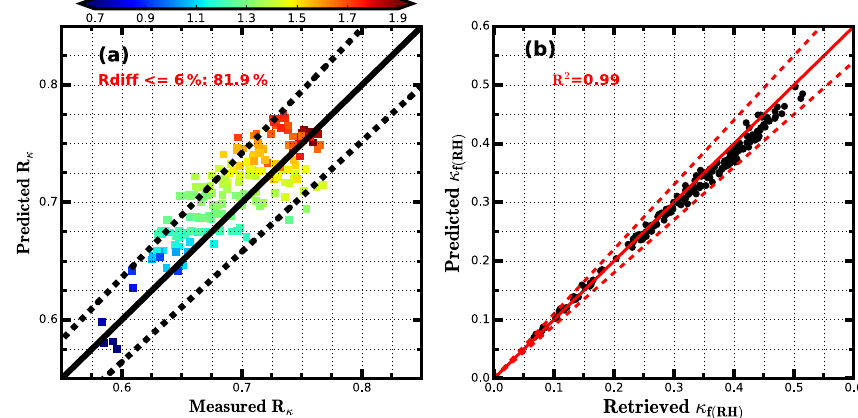
Figure 7. (a) The comparison between measured and predicted R κ values. Colors represent values of Ångström exponents, texts with red color show the percentile of points with a relative difference (Rdiff) less than 6%, and the two dashed lines are 6% relative difference lines. (b) The comparison between κ f( RH ) retrieved from Method 1 and predicted κ f( RH ) using the new method introduced in Sect. 4.3. R 2 is the square of the correlation coefficient; the two dashed lines are 10% relative difference lines.